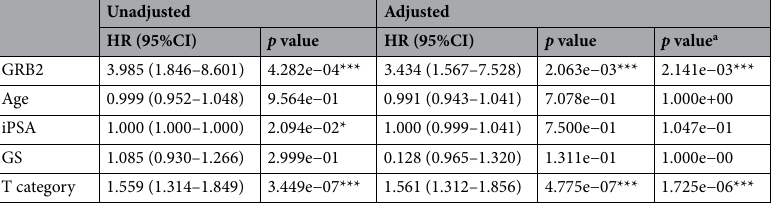
Table 5. Multivariate analysis of the effect of GRB2 expression on survival (based on data from clinical samples). GRB2 cut off, H-score ≥ 69.8532; iPSA: initial PSA; GS: Gleason score; “*” and “***” indicate p value < 0.05 and < 0.001, respectively. a Adjusted p value (using a Bonferroni correction).